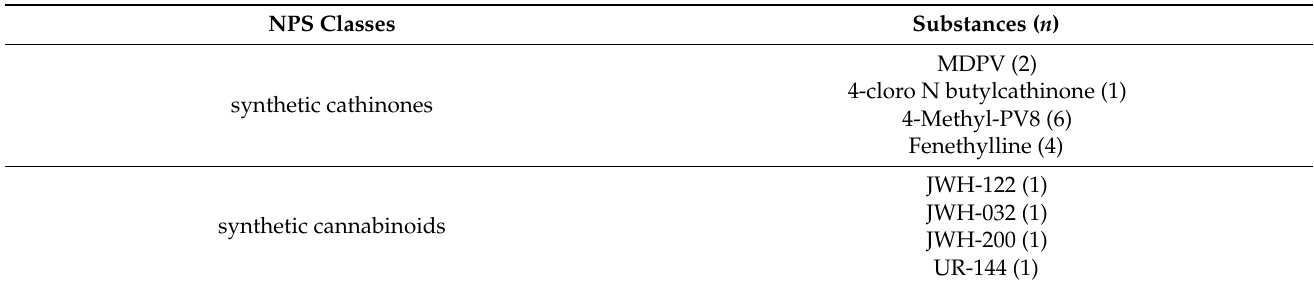
Table 3. New psychoactive substances(NPS) found in urine samples under investigation.